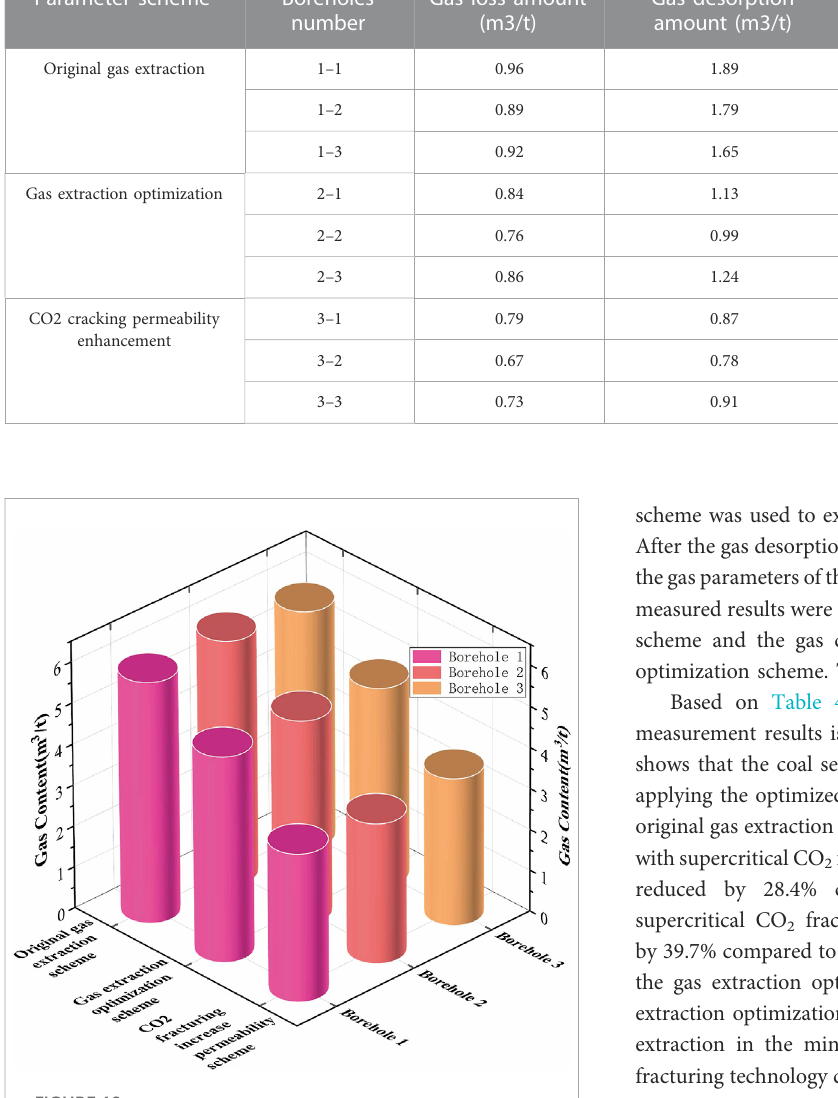
FIGURE 10 Comparison diagram of gas content measurement